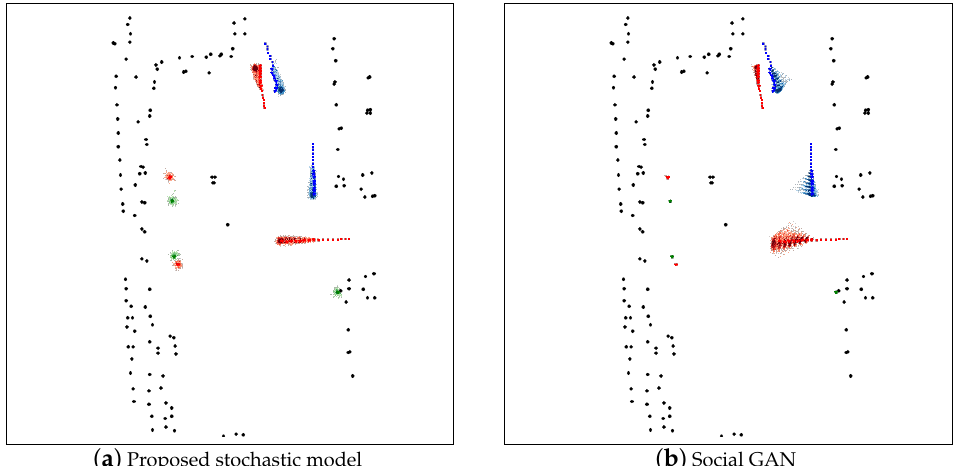
Figure 5. Graphical result of the compared stochastic